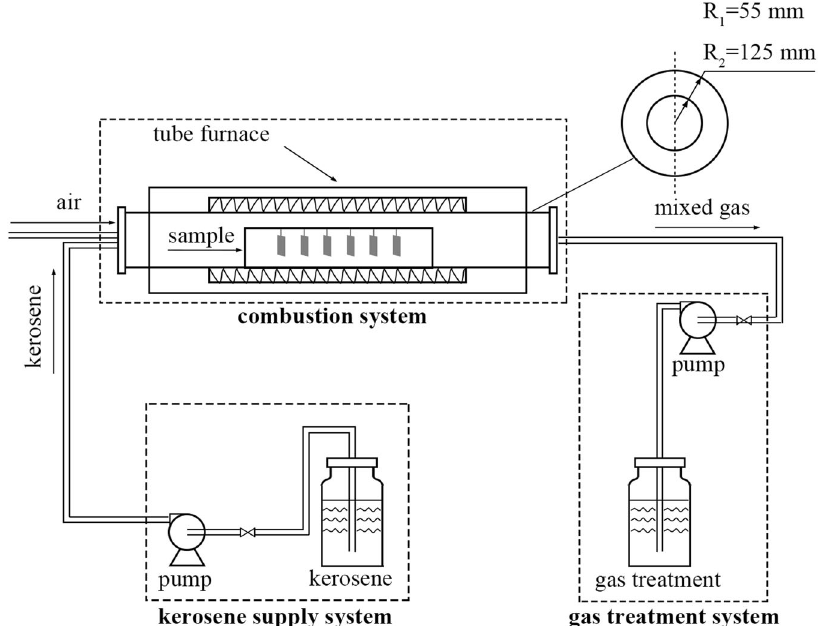
Fig. 9 Device schematic. Schematic diagram of the simulation device of kerosene